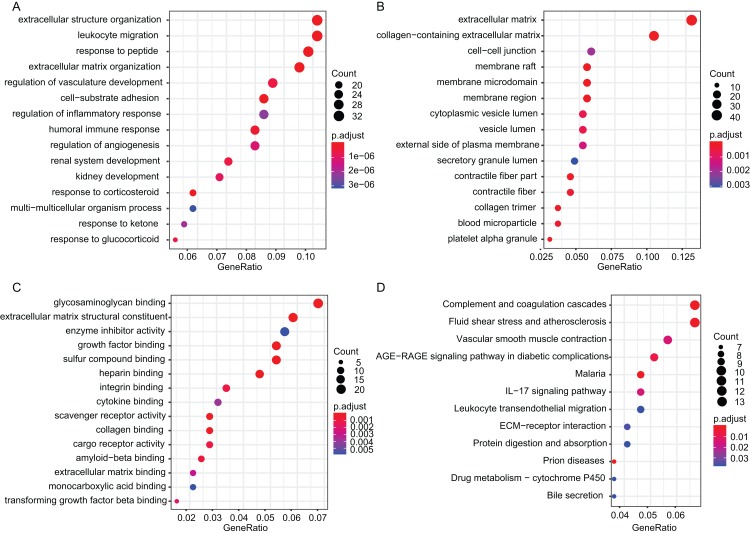
GO and KEGG analysis of DEGs.(A–C) The top 15 terms of GO categories of biological process (BP), cellular component (CC) and molecular function MF, respectively. (D) KEGG pathway analysis of DEGs, p.adjust (FDR) < 0.05 was considered significantly. GO, Gene Ontology; KEGG, Kyoto Encyclopedia of Genes and Genomes; FDR, false discovery rate.